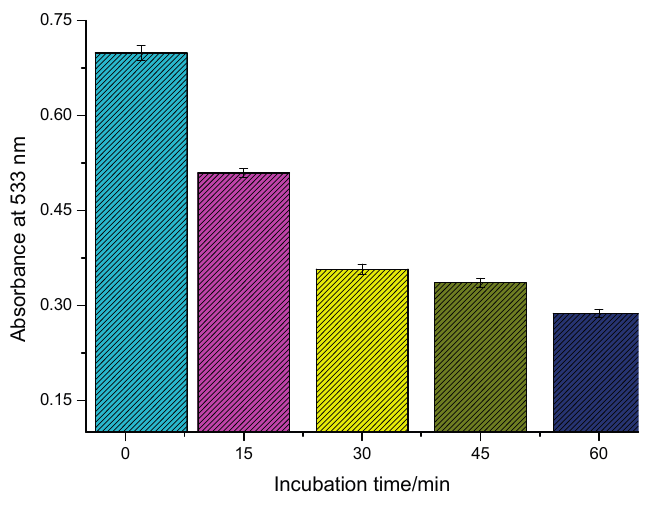
Figure 3. The effect of incubation time on the absorbance of supernatant.